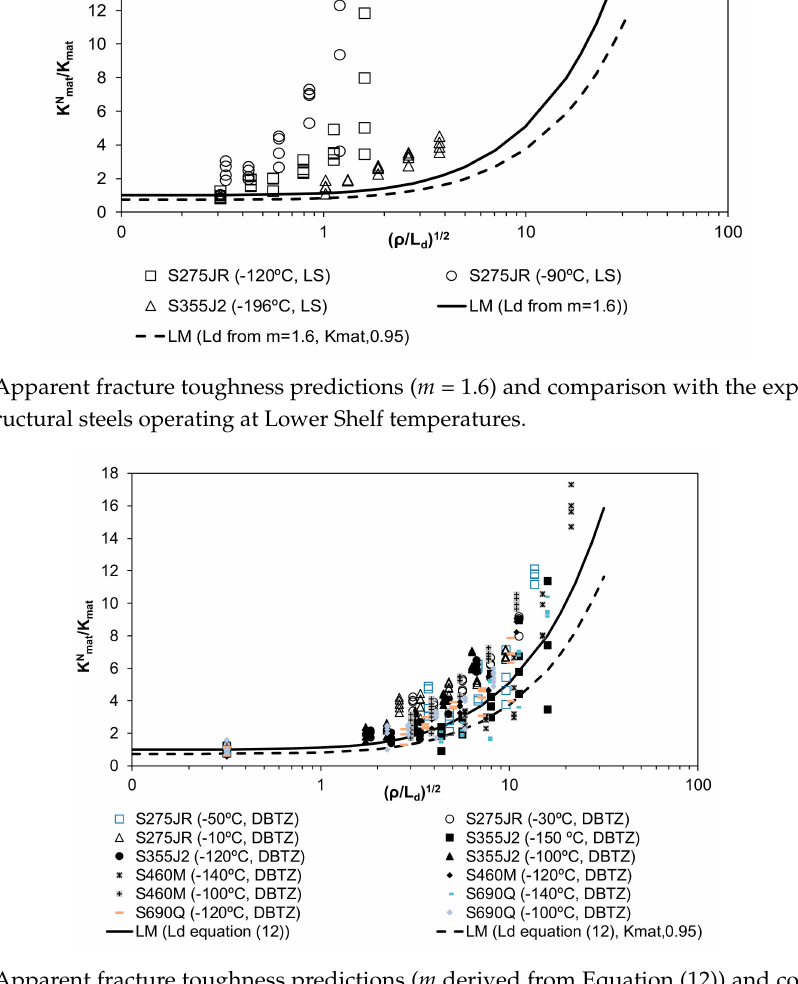
Figure 6. Apparent fracture toughness predictions ( m derived from Equation (12)) and comparison with the experimental results. Structural steels operating at the